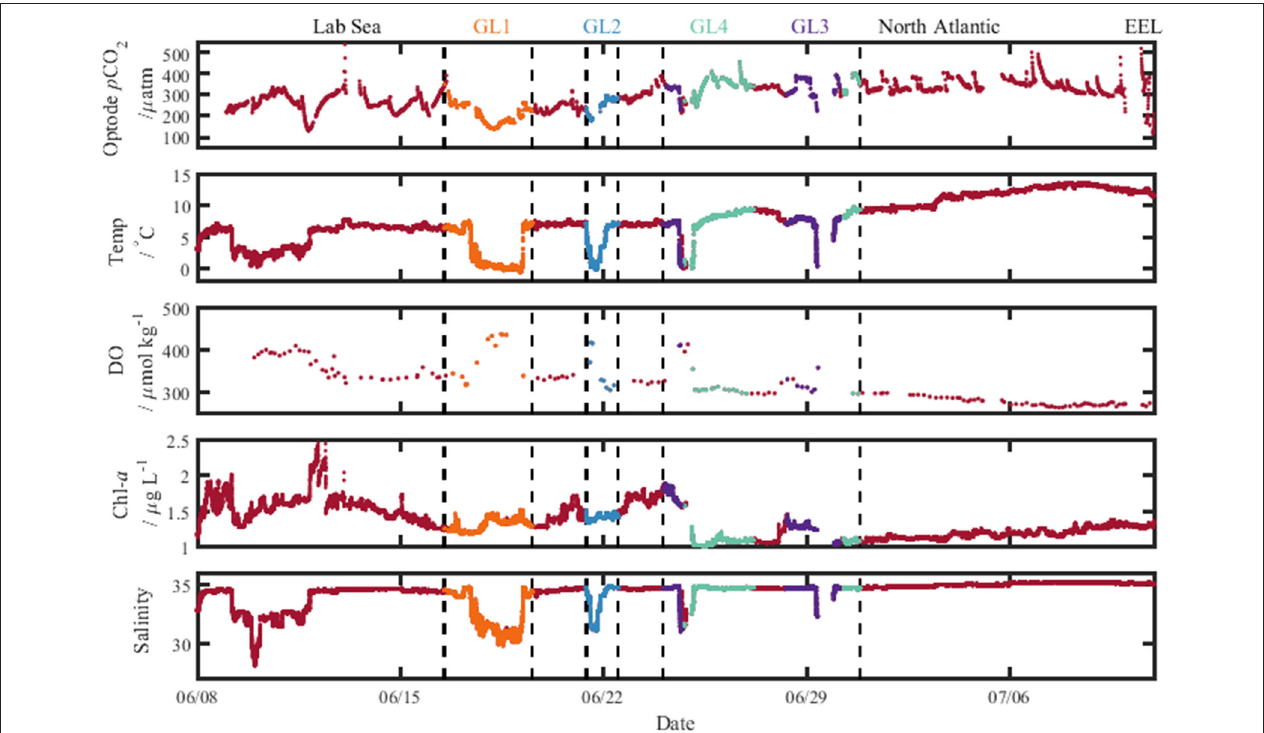
FIGURE 9 | Plots of the measured variables from the ship’s underway seawater supply along the cruise track, with pCO 2 determined using the optode sensor. The different colors indicate data collected on the sections toward Greenland labeled at the top (GL1–4). Lab Sea, Labrador Sea; and North Atlantic, Irminger Basin; EEL, extended Ellett Line.